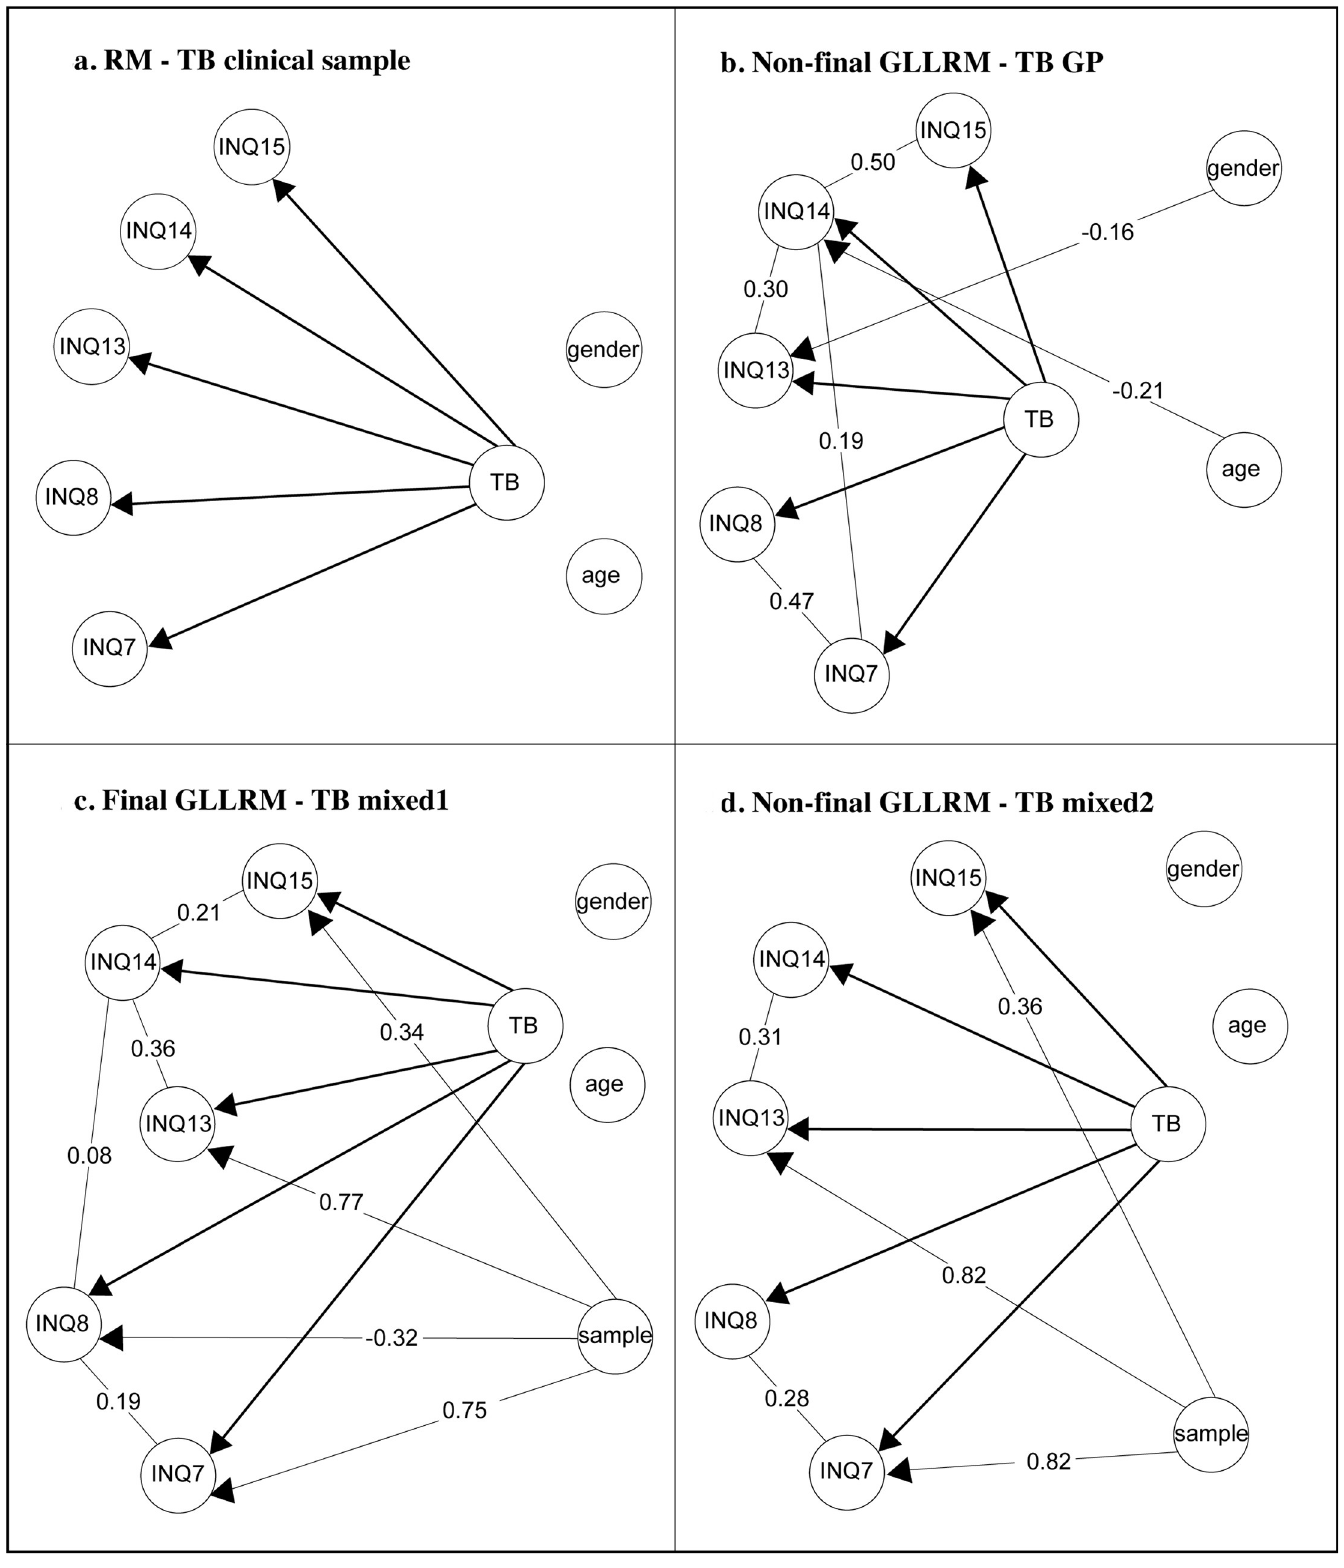
Fig 2. The Rasch model and graphical loglinear Rasch models for the TB-subscale. Lines between items show evidence of LD, arrows pointing from the exogeneous variables to the items evidence of DIF. Note. γ -correlations are partial Goodman and Kruskal’s rank correlations for ordinal data. https://doi.org/10.1371/journal.pone.0232030.g002 PLOS ONE | https://doi.org/10.1371/journal.pone.0232030 August 3,